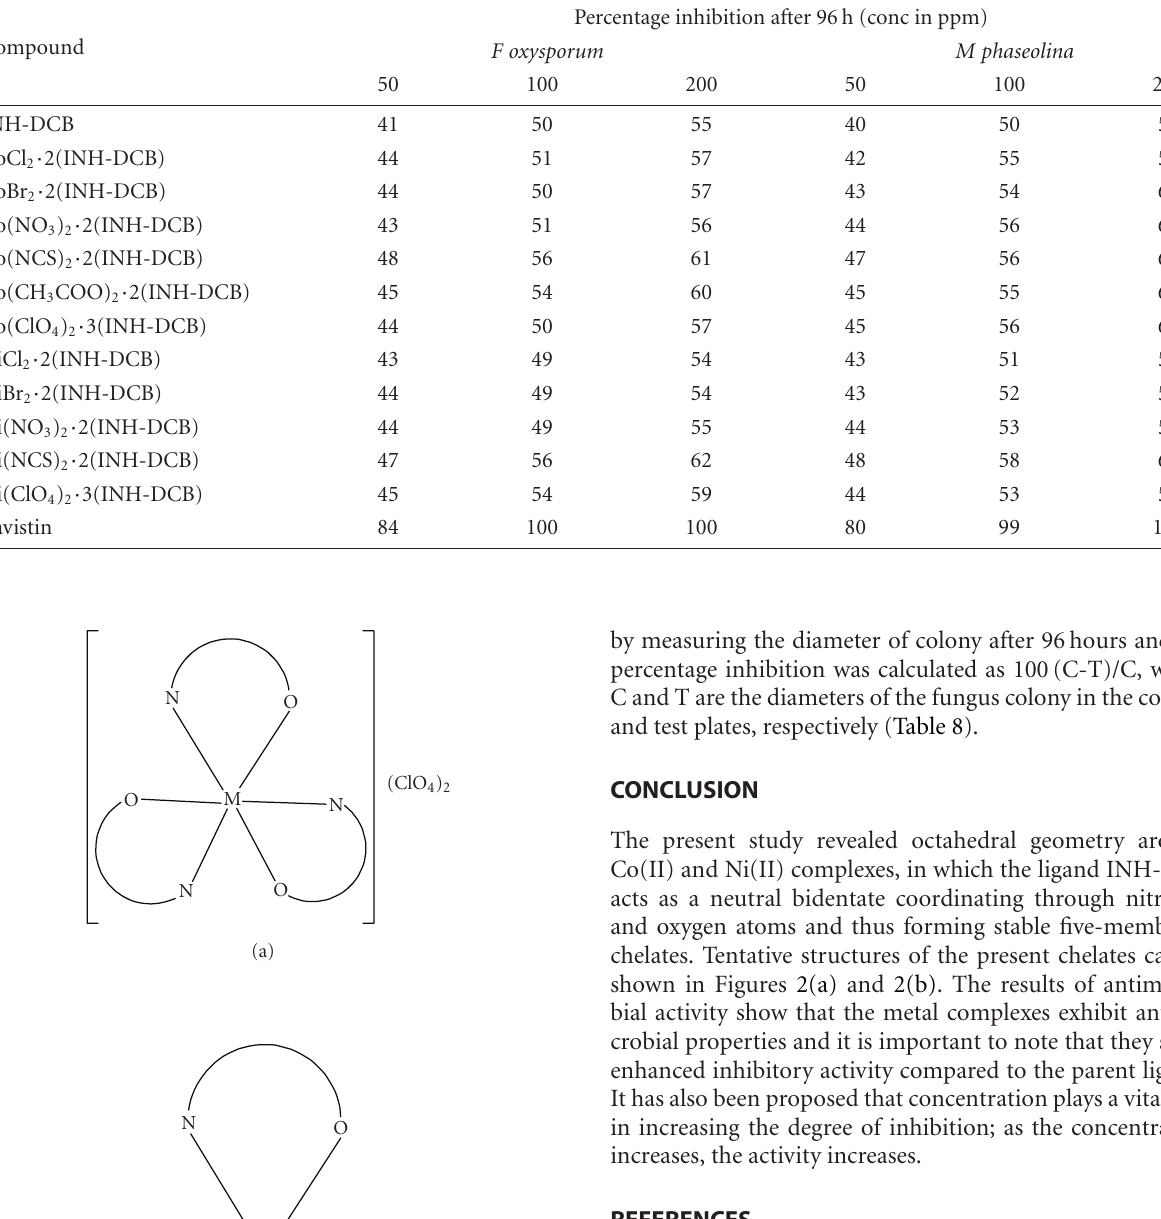
Table 8: Fungicidal screening data of INH-DCB and its Co(II) and Ni(II) complexes. Percentage inhibition after 96 h (conc in ppm) Compound